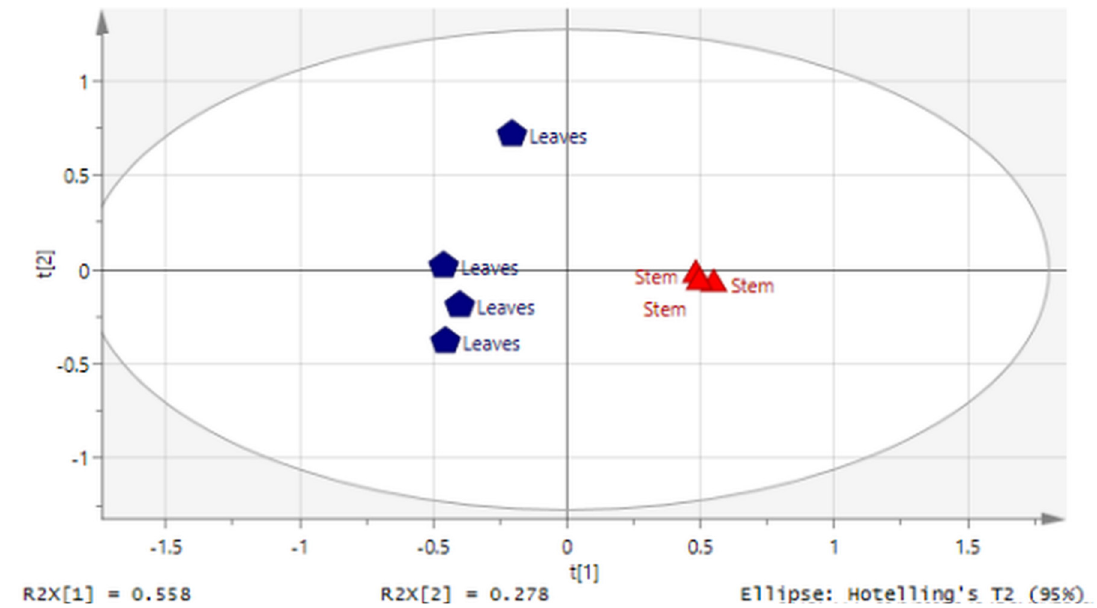
Figure 6. The respective principal component analysis (PCA) score plots of 1 H NMR data representing Clinacanthus nutans